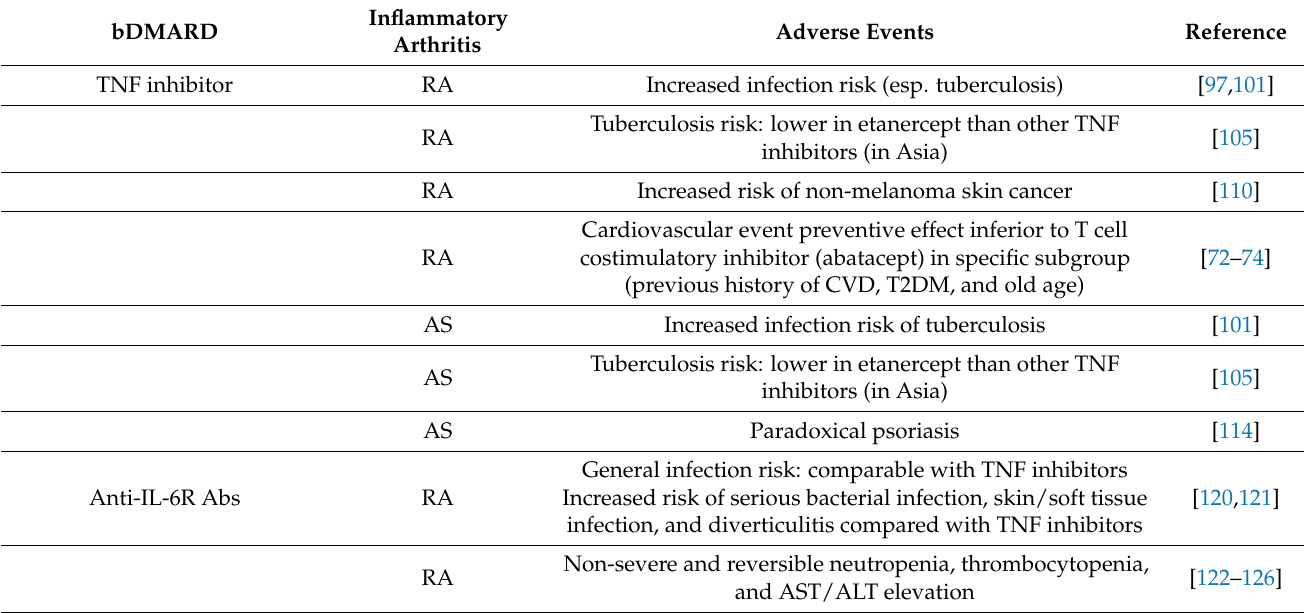
Table 3. Specific adverse events of bDMARDs in patients with inflammatory